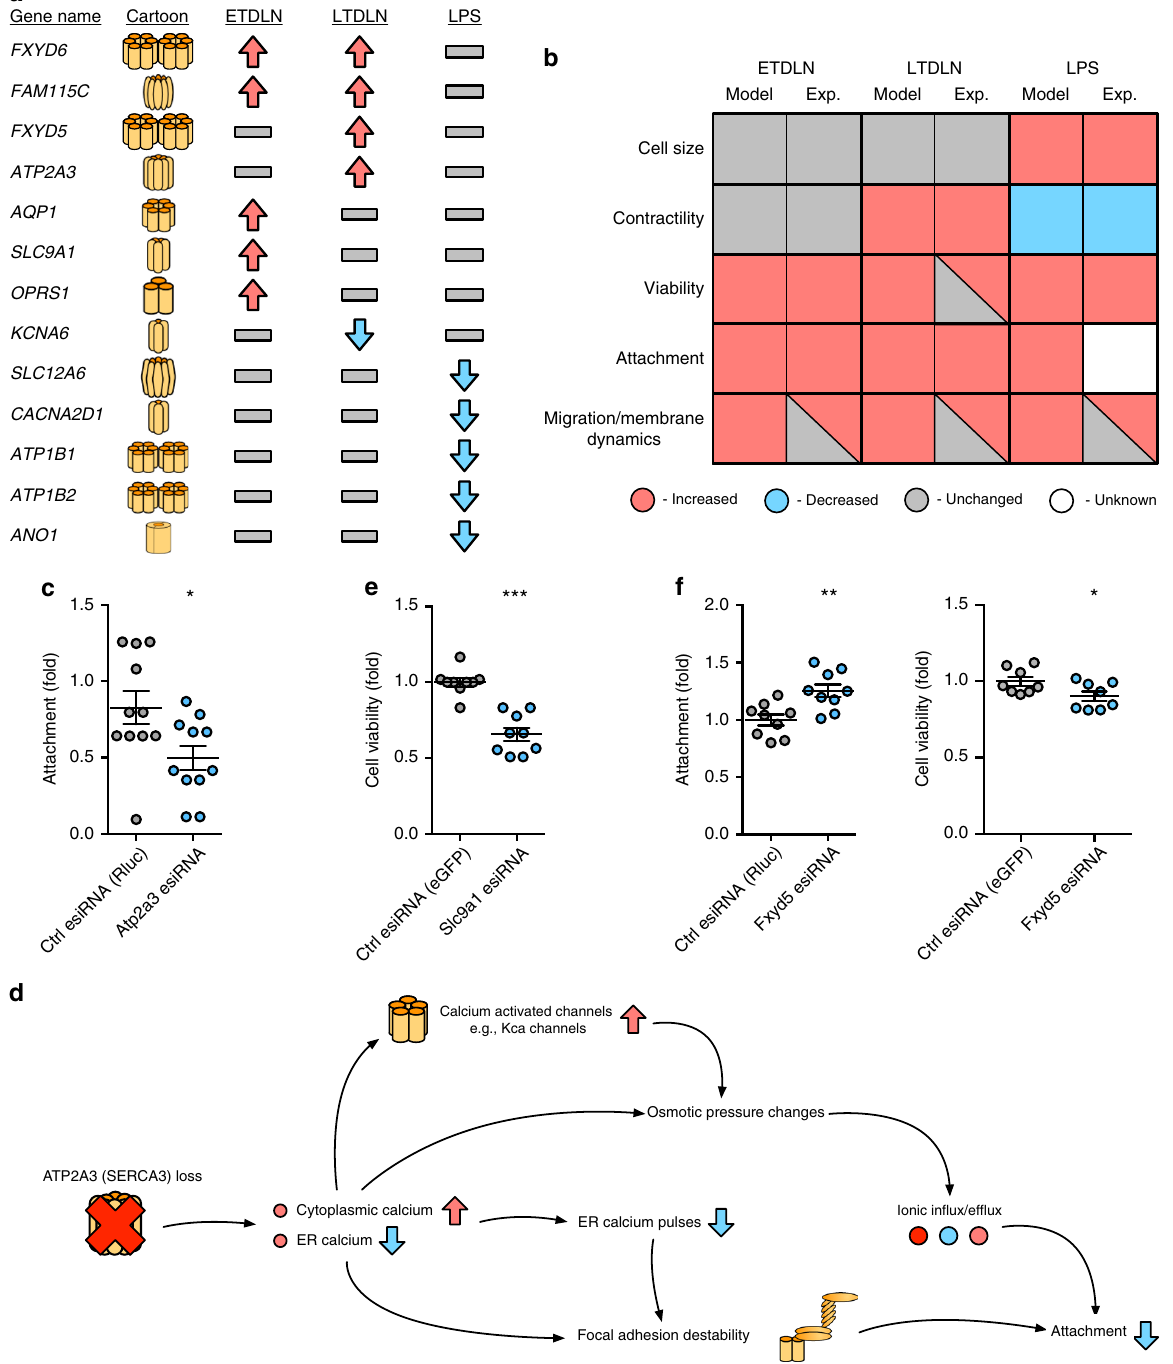
Fig. 4 The qualitative network explains cellular phenotypes of Stromal cells in varying experimental conditions. Membrane proteins deregulated under varying stimuli, showing a Transport proteins deregulated in Early (ETDLN) and Late (LTDLN) stage after exposure to TFs, and after exposure to LPS. Proteins are upregulated (red arrows), downregulated (blue arrows), or unchanged (grey) in response to TFs or LPS. b Phenotype change for FRCs upon exposure to TFs for Early (ETDLN) and Late (LTDLN) stage. The Model output represents the physiological behaviour predicted by the model, and the experimental output represents the behaviour observed or implied at the cellular level from experiments or the gene array, and is independent of the model (see methods). Boxes containing two colours indicate phenotypes where there is contradictions/data is unclear. The model predicts an increase in viability, and a sustained increase in attachment and movement/membrane dynamics. Speci fi c protein activity loss predictions are veri fi ed with experiments. c , d Knockdown of genes for ( c ) ATP2A3 , and its effect on cellular attachment. The cascade predicted by the model to be underpinning this behaviour change is seen in part ( d ). e , f Also shown are siRNA knockdowns for SLC9A1 and its effect on cell viability ( e ), and FXYD5 and its effect on viability and attachment ( f ). Predicted mechanisms for these knockdowns are included in Supplementary Fig. 6. * P < 0.05, ** P < 0.01, *** P < 0.001 using two-tailed unpaired t -test. Error bars represent standard deviation. Shown are 11 replicates ( c ), and 9 replicates ( e , f